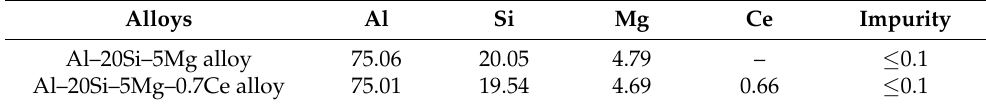
Table 1. Chemical ingredients of hypereutectic Al–Si alloys (wt.%).